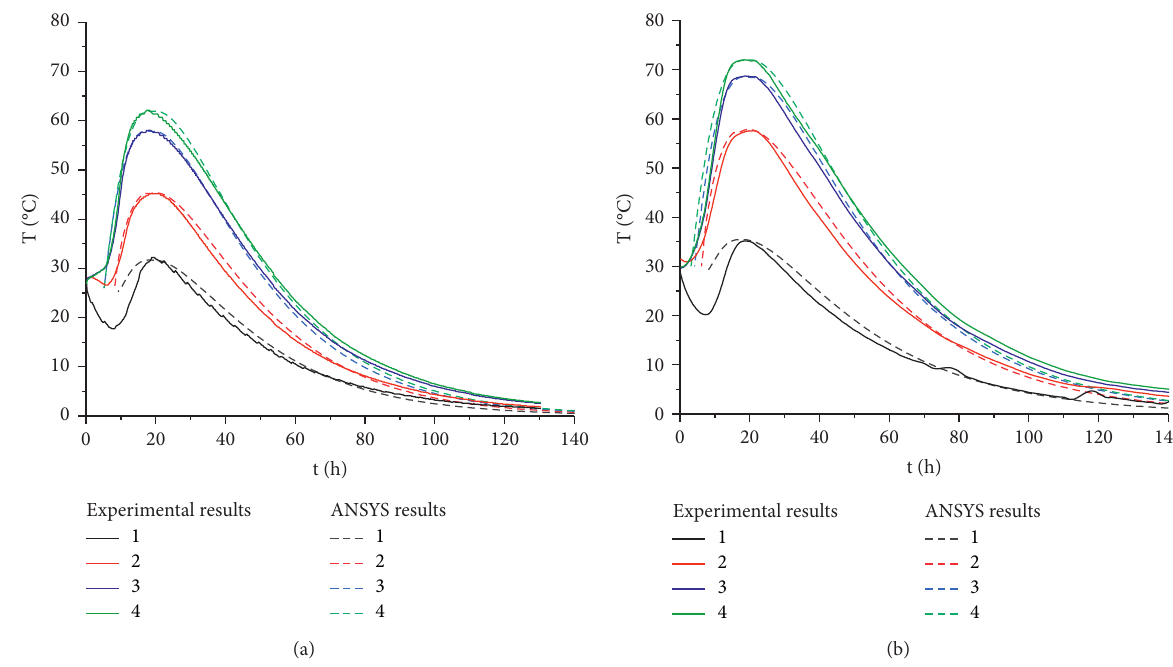
Figure 7: Comparison of experimental and finite element simulation results for (a) 1.4 m and (b) 1.6-m diameter